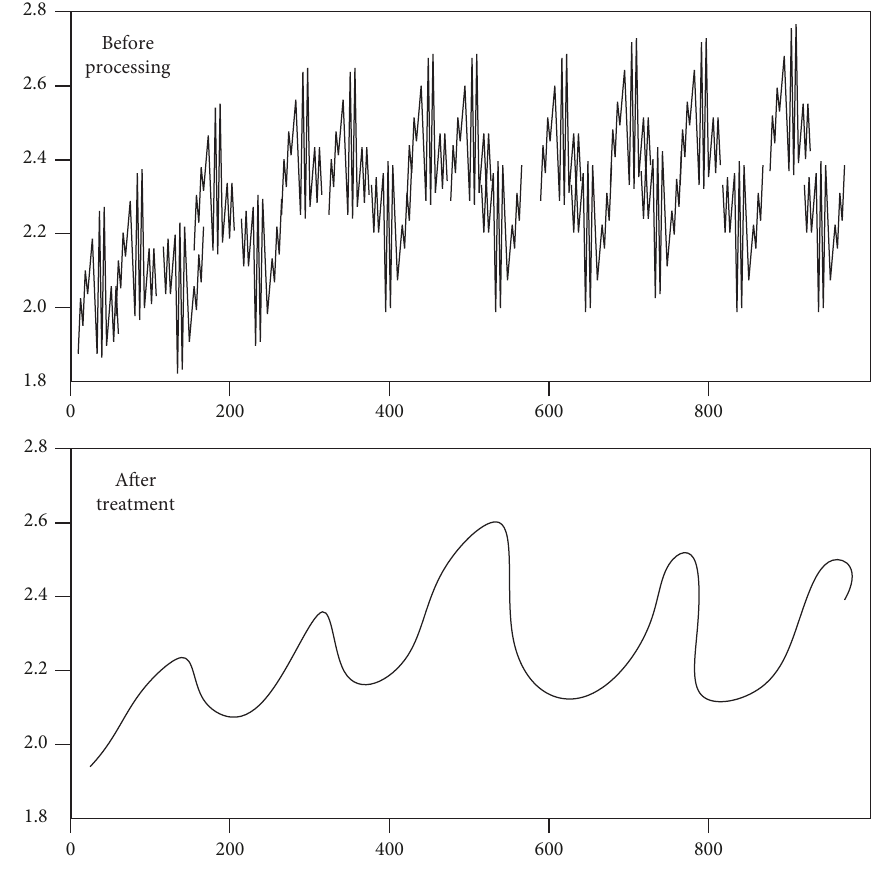
Figure 5: Signal sequence before and after wavelet transform processing.